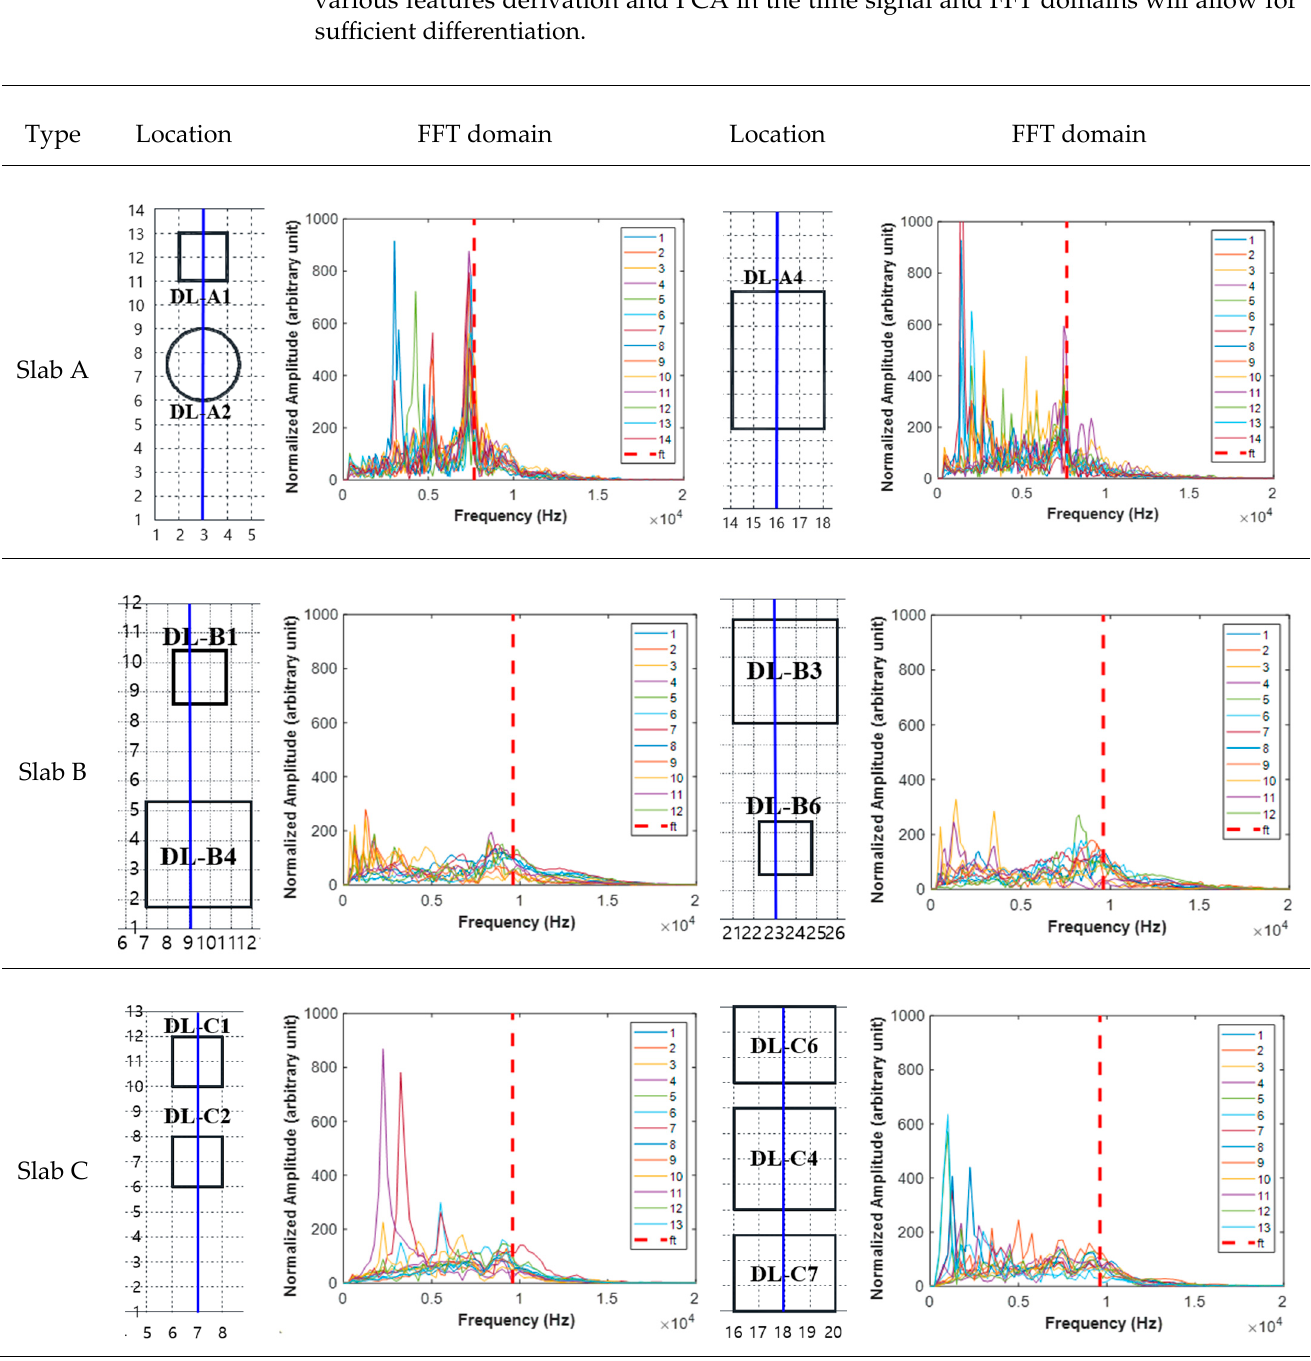
Figure 7. Representative spectrum by defect type and slab.